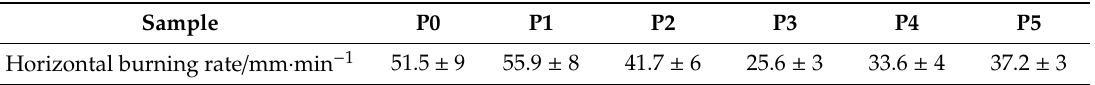
Table 5. Horizontal combustion data of flame-retardant RPUF